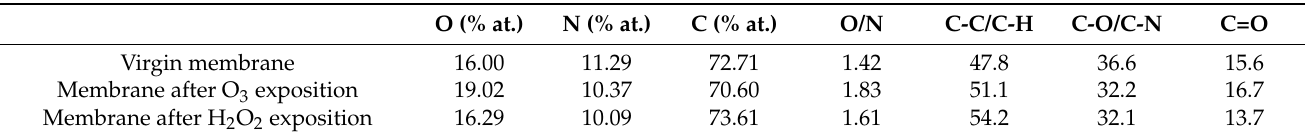
Table 3. Quantitative analysis of membrane components of the new membrane HL (GE Osmionics) and after ozone or H 2 O 2 exposition, based on the XPS spectroscopy.